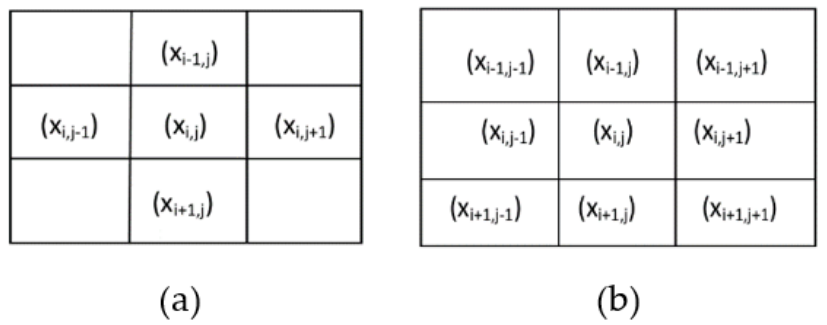
Figure 5. Neighborhood structure. ( a ) first order and ( b ) second order.